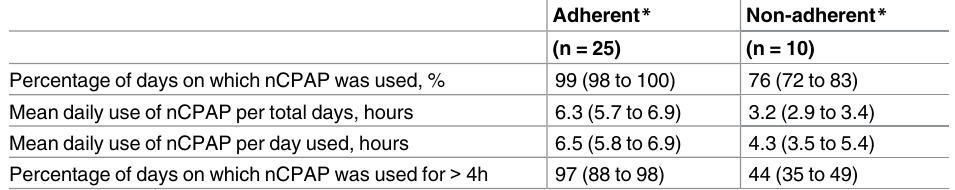
Table 2. nCPAP adherence